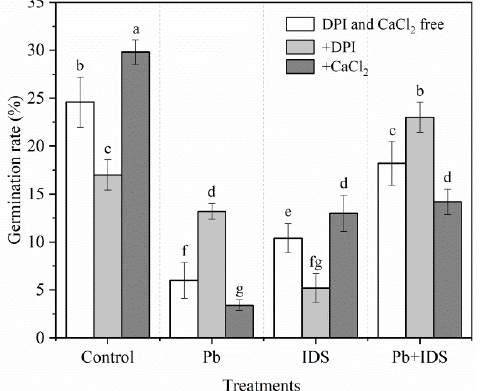
Figure 5. Effects of DPI and CaCl 2 on the germination of maize seeds treated with IDS, Pb, or Pb+IDS. Maize seeds treated with distilled water (control), Pb (20 mmol · dm − 3 PbCl 2 ), IDS (100 mmol · dm − 3 ), or Pb+IDS were further treated with DPI or CaCl 2 for 1 d. Error bars represent the standard deviation of the mean ( n = 5). Means associated with different letters are significantly different among treatments and time points ( p < 0.05; Duncan’s new multiple range test). Pb, lead; IDS, iminodisuccinic acid; DPI, diphenyleneiodonium